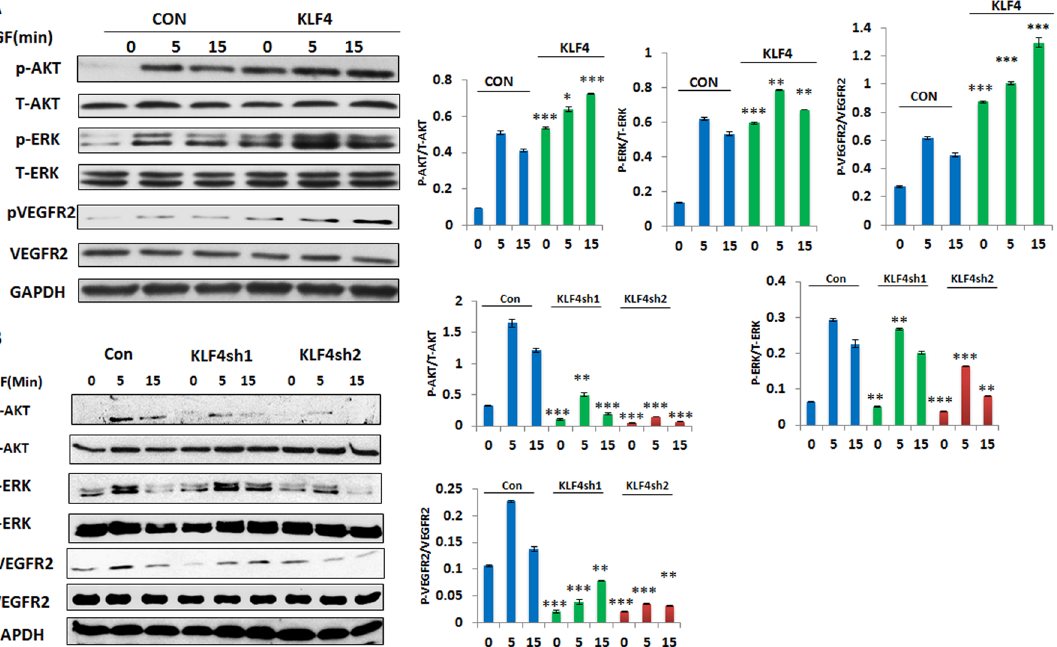
Fig 4. KLF4 enhances VEGF mediated angiogenesis signaling pathway. A.B. VEGF signaling pathway was examined in KLF4 expressing and knockdown HRMECs following serum starvation and VEGF treatment using Western blot. Data were presented from three separate experiments by measuring band density using the Image J program. Western blot was shown from one representative experiment. Significance was compared between KLF4 expressing and control cells at different time points of VEGF treatment ( * p < 0.05, ** p < 0.01, *** p < 0.001).